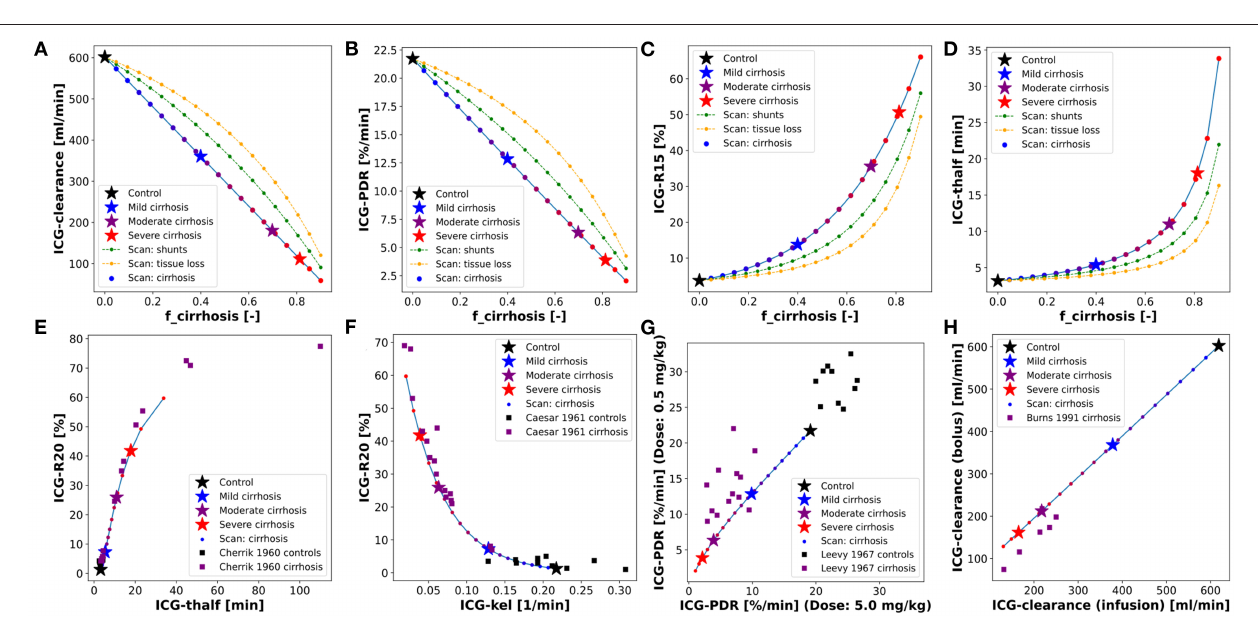
FIGURE 4 | Dependency of ICG pharmacokinetic parameters on cirrhosis. Simulations of 4 specific cirrhosis degrees are indicated by stars. (A–D) Dependency of ICG pharmacokinetic parameters on the degree of shunting (green), degree of tissue loss (yellow) and degree of cirrhosis (black-blue-red). (E) Correlation between ICG-R20 and ICG-t 1 / 2 in cirrhotic and control subjects (Cherrick et al., 1960). (F) Correlation between ICG-R20 and ICG-kel in cirrhotic and control subjects (Caesar et al., 1961). (G) Correlation between ICG-PDR after an ICG dose of 0.5 and 5.0 mg/kg in control subjects and subjects with various liver diseases (Leevy et al., 1967). (H) Correlation between ICG-clearance after a bolus administration and during a constant infusion of ICG in cirrhotic subjects (Burns et al., 1991).